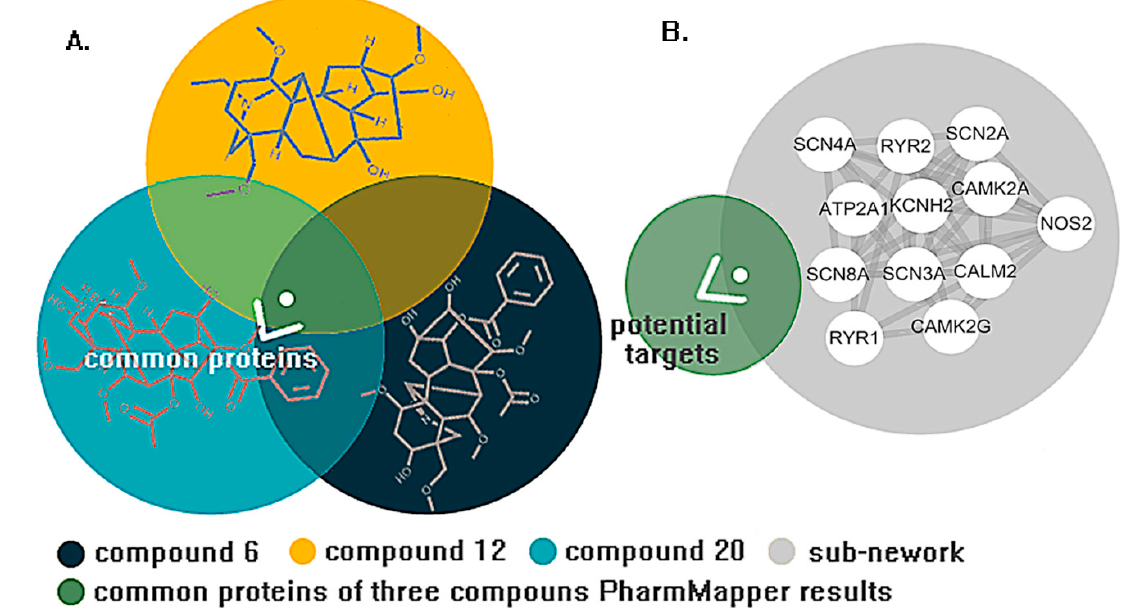
Figure 5. ( A ) Common targets of three aconitine alkaloids obtained from overlapping the PharmMapper results. ( B ) The potential target received from superimposing the PharmMapper and CytoNCA result.